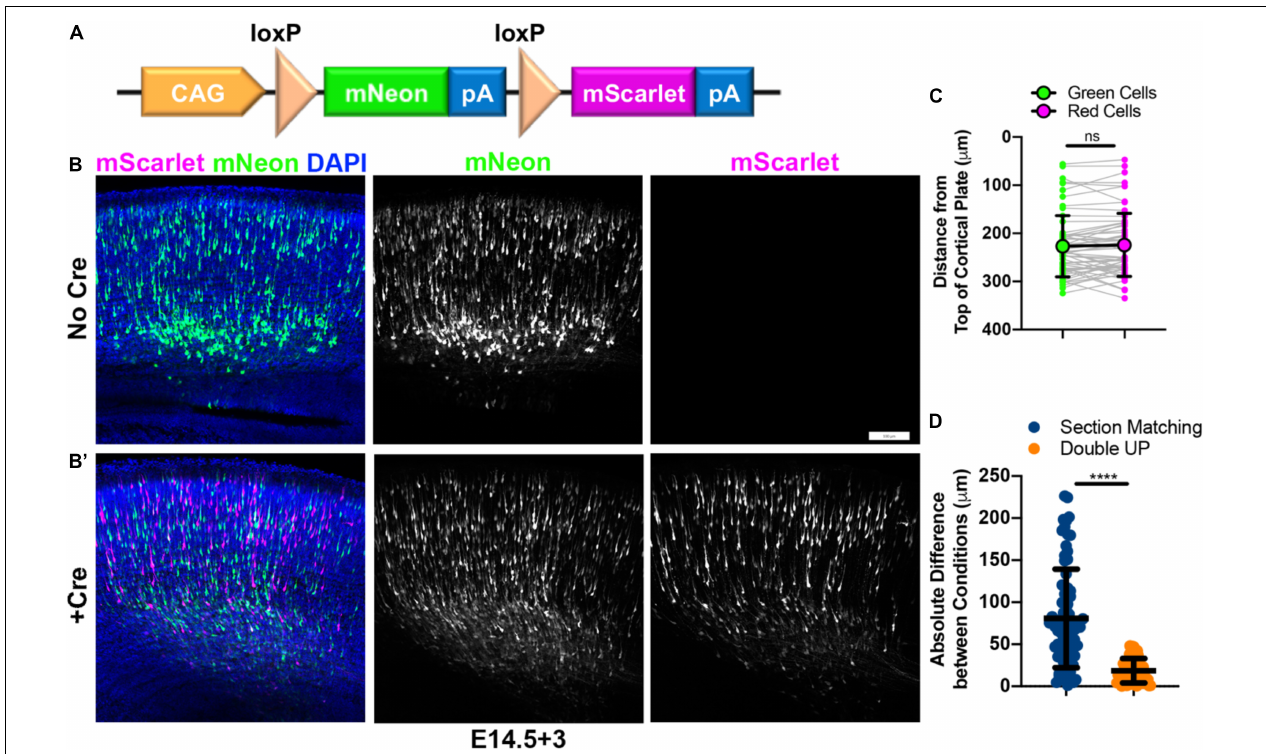
FIGURE 1 | Construction and characterization of Double UP. Double UP generates equivalent populations of red and green neurons within an individual slice. (A) Schematic of Double UP construct. Representative IUE of 2 µ g/ µ L Double UP without Cre (B) and with 15 ng/ µ L pCAG-Cre (B’) . Embryos were electroporated at E14.5 and allowed 3 days to mature (E14.5+3). Scale bar, 100 µ m. (C) Comparison of migration of mNeon-Green- and mScarlet-positive cells, E14.5+3. Each dot represents the mean distance of all cells within one cortical slice to the top of the cortical plate. Connected dots indicate measures from the same slice ( n = 61 slices). Large dots and black line indicate mean and SD of all 61 slices. No significant difference was detected between green and red populations (two-way ANOVA). Full data shown in Supplementary Figure S1 . (D) Comparison of reliability of controls between section matching and Double UP. 76 comparisons were made for section matching and 61 comparisons were made for Double UP. Only sections that had a perfect match in another brain were included for either analysis. **** p < 0.0001, Kolmogorov–Smirnov t -test, two-tailed. Lines indicate mean and SD. See also Supplementary Figure S1